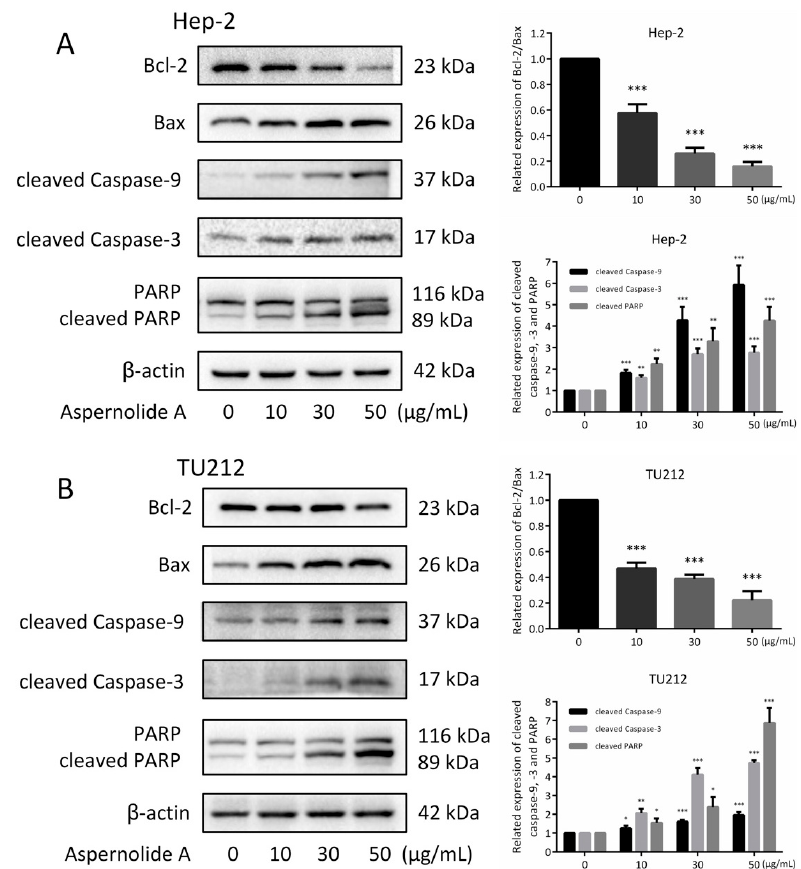
Figure 5. Effects of aspernolide A on the apoptosis regulatory proteins of laryngeal cancer cells. ( A , B ) The related expressions of Bcl-2/Bax, cleaved caspase-9, cleaved caspase-3 and cleaved PARP in Hep-2 and TU212 cells were detected by Western blotting. β -actin was used as a control. (* p < 0.05, ** p < 0.01 or *** p < 0.001).